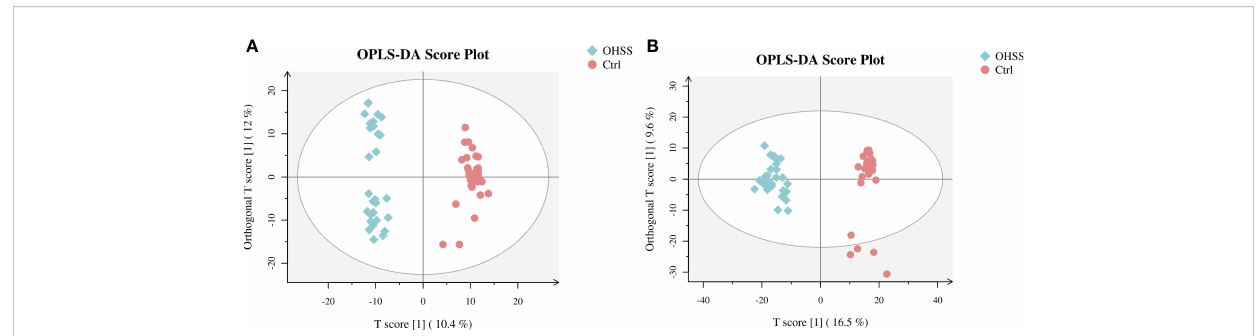
FIGURE 3 OPLS-DA score plots of two ESI modes based on follicular fl uid metabolic pro fi ling of OHSS group and the control group. (A) ESI positive mode, model parameters: R2Y=0.977, Q2 = 0.839; (B) ESI negative mode, model parameters: R2Y=0.95, Q2 = 0.827. One point stands for one subject, red circles represent the control, blue diamonds represent OHSS.